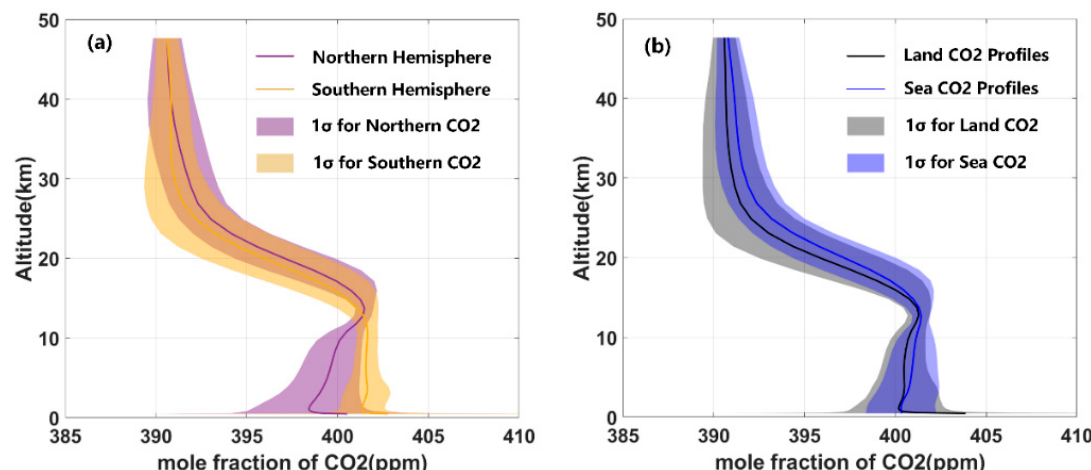
Figure 9. ( a ) The vertical CO 2 profiles of northern (in khaki color) and southern (in purple color) hemisphere changing with altitudes. ( b ) The vertical CO 2 profiles of land (in gray color) and southern (in blue color) hemisphere changing with altitudes. The solid line stands for the mean mole fraction of CO 2 , and the transparent shadow is the standard deviation of CO 2 in corresponding